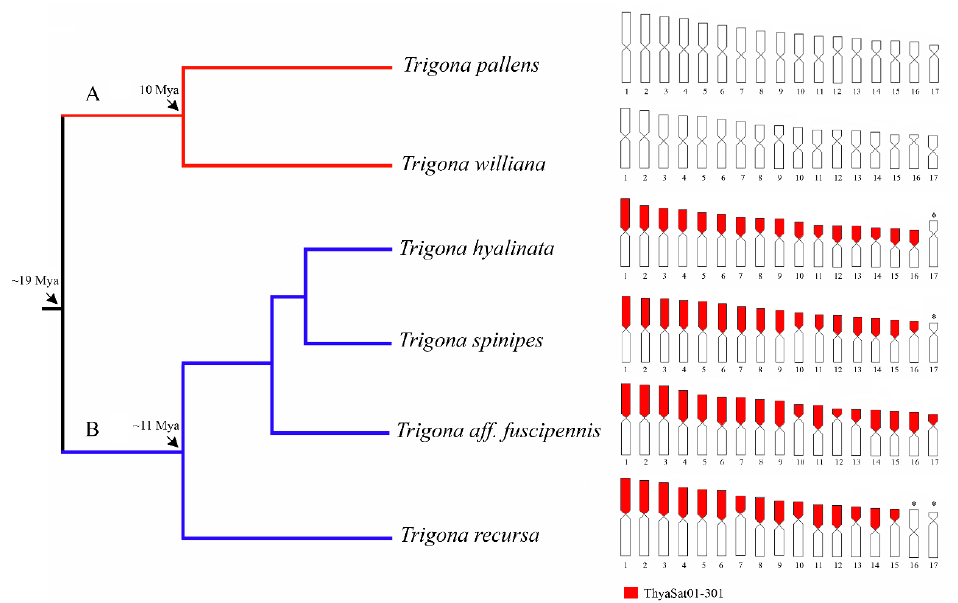
Figure 4. Simplified phylogeny for Trigona species based on Rasmussem and Camargo [20], Ras- mussen and Cameron [21]. The ideograms on the right show the distribution of ThyaSat01-301 on the Trigona karyotypes. (*) Chromosomes in which no signs of ThyaSat01-301 were observed. Note that ThyaSat01-301 is located on the heterochromatic arm of chromosomes in clade B species (blue), but it is not present in clade A species (red).